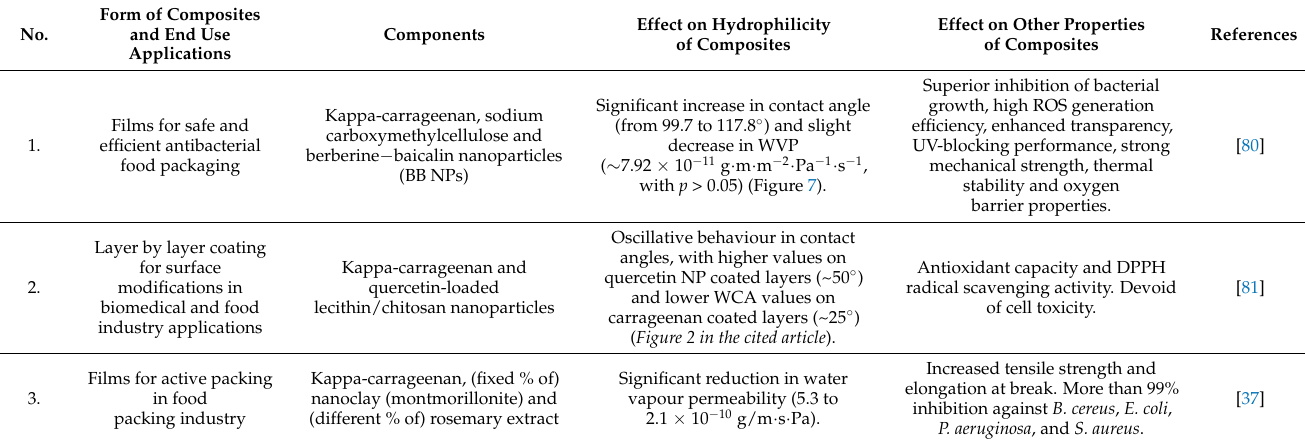
Table 11. Role of bioactive agents in carrageenan-based